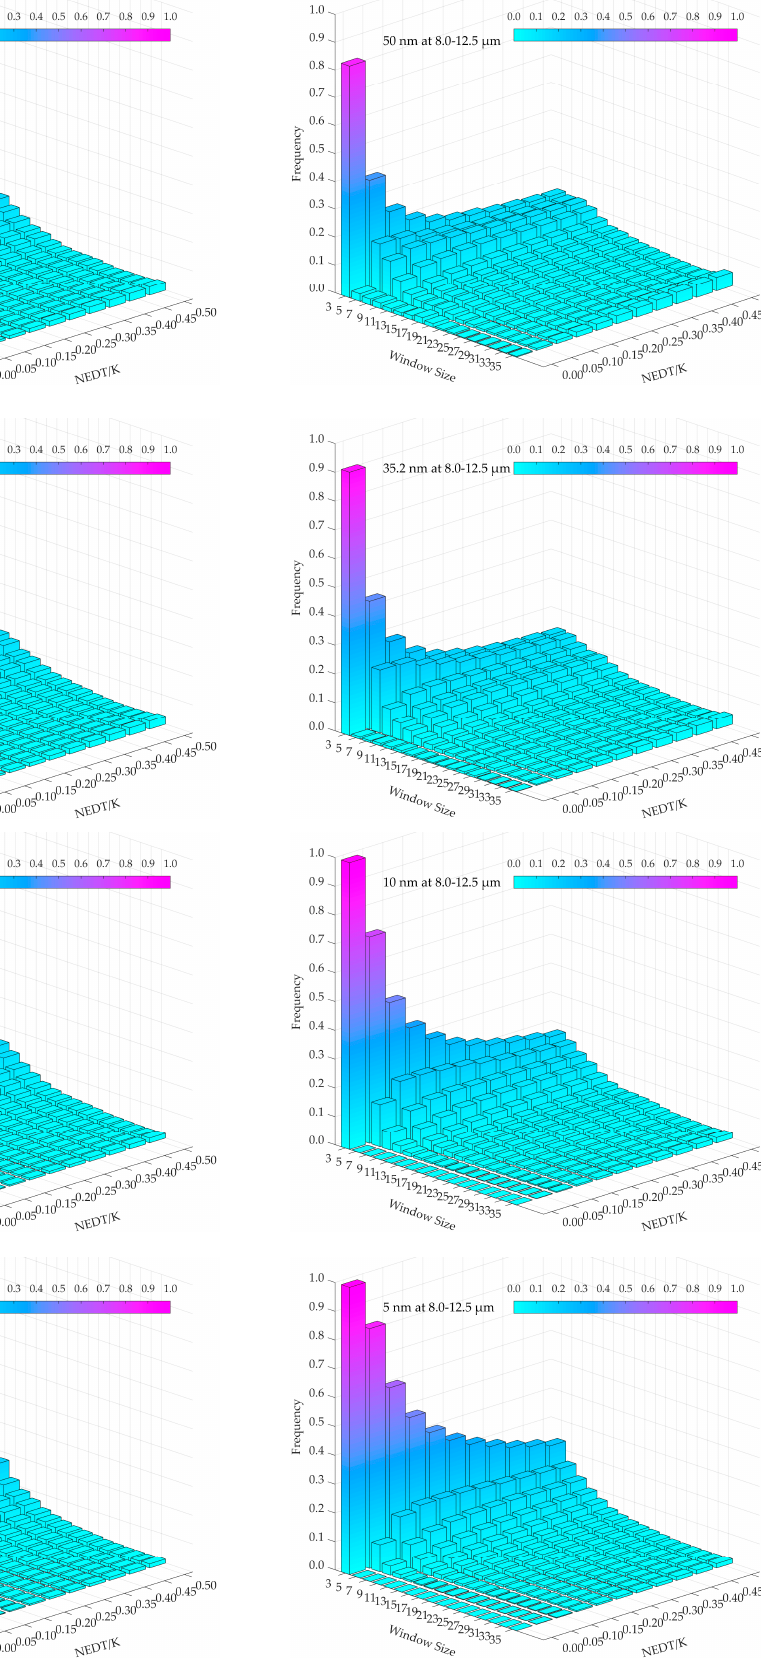
Figure 4. The distribution of the optimal spectral smoothing window size varying with the noise level.